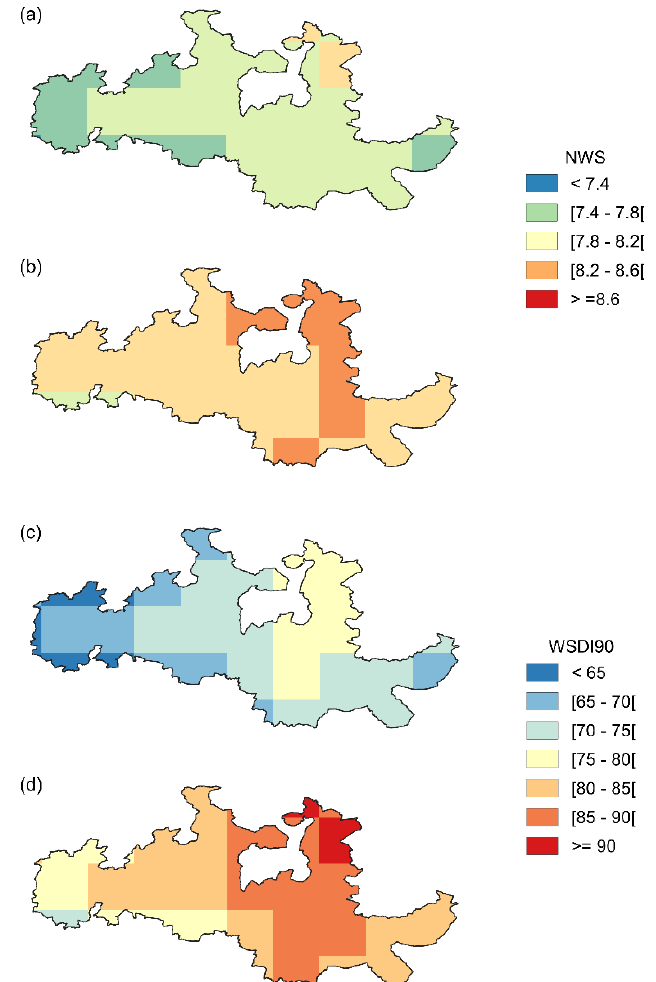
Figure 5. Ensemble-mean of the Number of Warm Spells (NWS) for the Douro Wine Region and the future period (2051–2080), under the RCP8.5, with a bias correction following the ( a ) linear and ( b ) quantile mapping methods. ( c , d ) The same as ( a , b ) but for the Warm Spell Day Index above the 90th percentile (WSDI90).